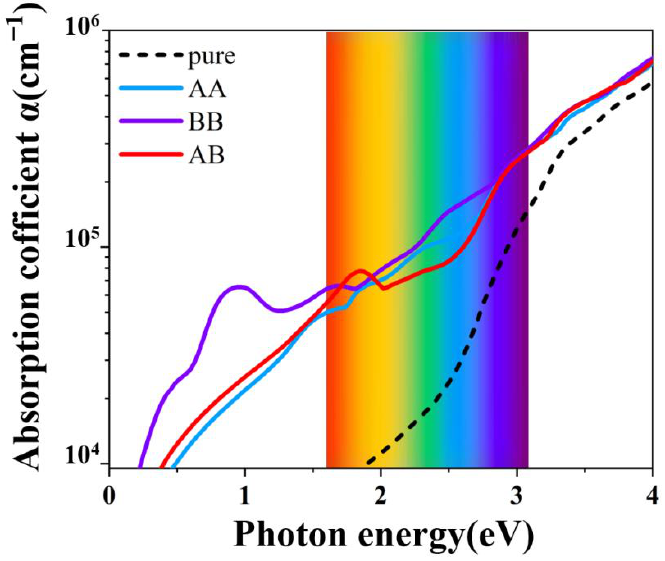
Figure 6. AA, AB, BC, and pure α -MoO 3 light